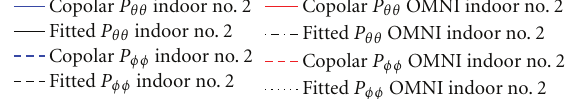
Copolar P θθ indoor no. 2